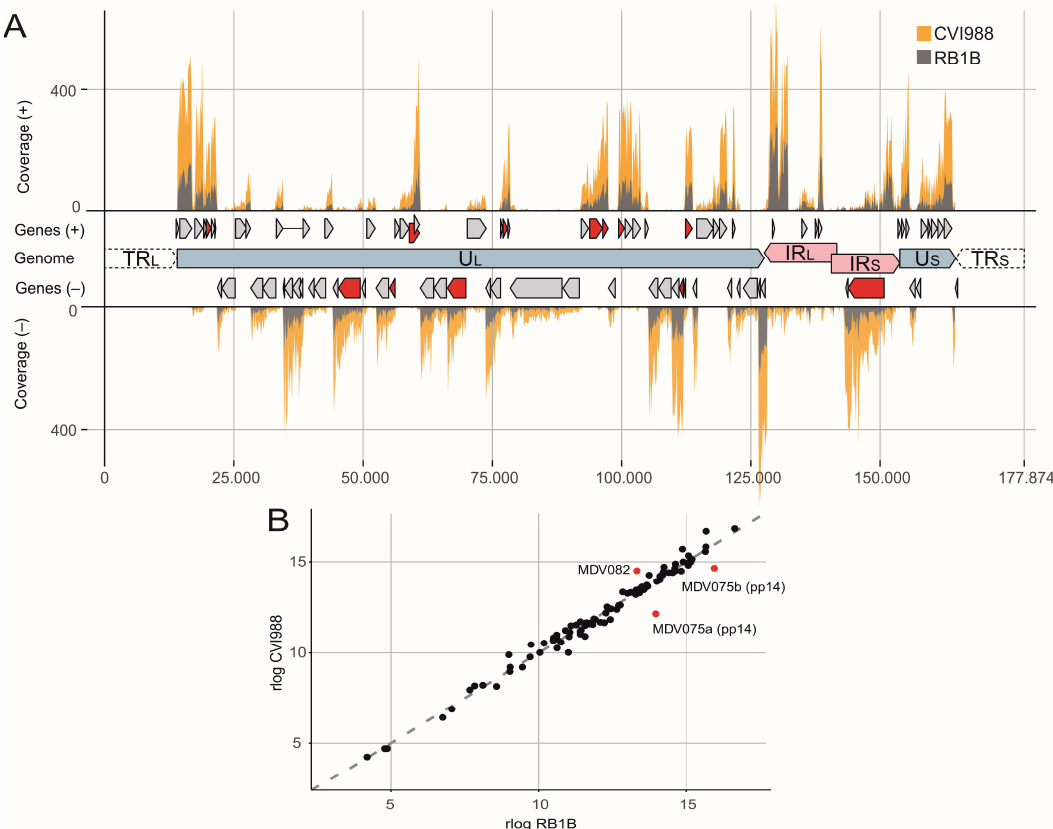
Figure 1. The Marek’s disease virus (MDV) transcriptome and proteome in in vitro infected primary chicken B cells. ( A ) Visualization of the deduplicated and strand-specific RNA-seq read coverage of plus (+) and minus (-) strand-encoded genes across the MDV genome. Orange curves indicate CVI988 reads and grey curves indicate reads for RB1B (with the respective annotated genes as grey arrow bars). Red bars depict proteins identified by MS. The two unique regions, unique long (U L ) and short (U S ) are flanked by terminal (TR L and TR S ) and internal (IR L and IR S ) inverted repeat regions. Nucleotide position numbers are derived from [12] . ( B ) Gene expression scatterplot comparing normalized expression levels (rlog) in RB1B and CVI988 infected primary chicken B cells. Red dots indicate significantly differentially expressed genes.